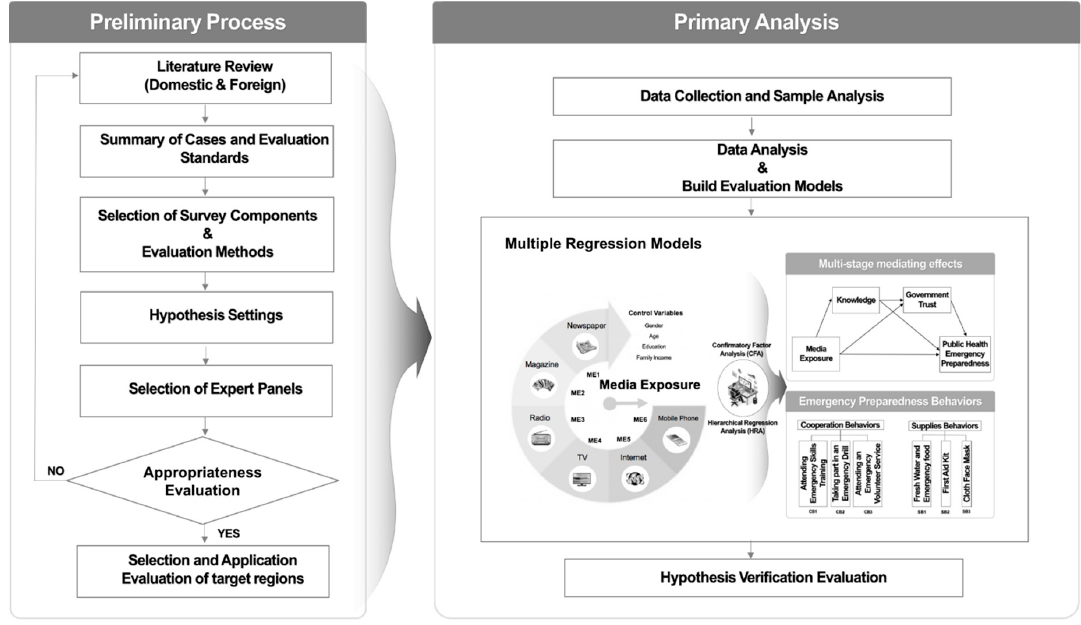
Figure 3. Preliminary analysis process and hypothesis verification procedures of this study.